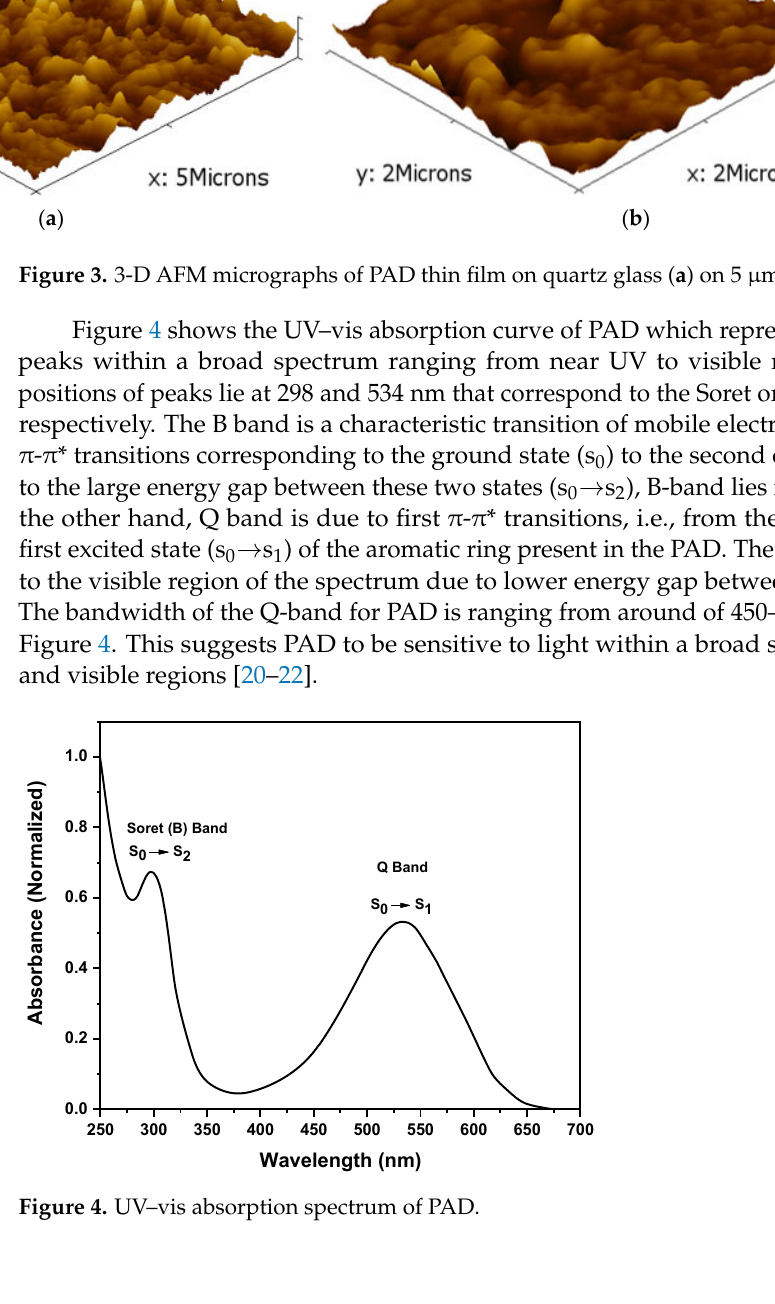
Figure 5. FTIR spectrum of PAD.